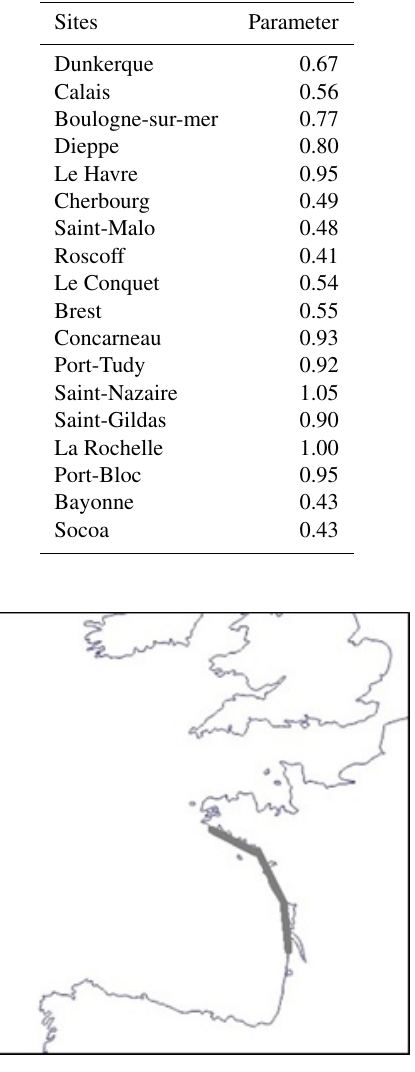
Figure 9. The coast with the maximal dependence from Concarneau to